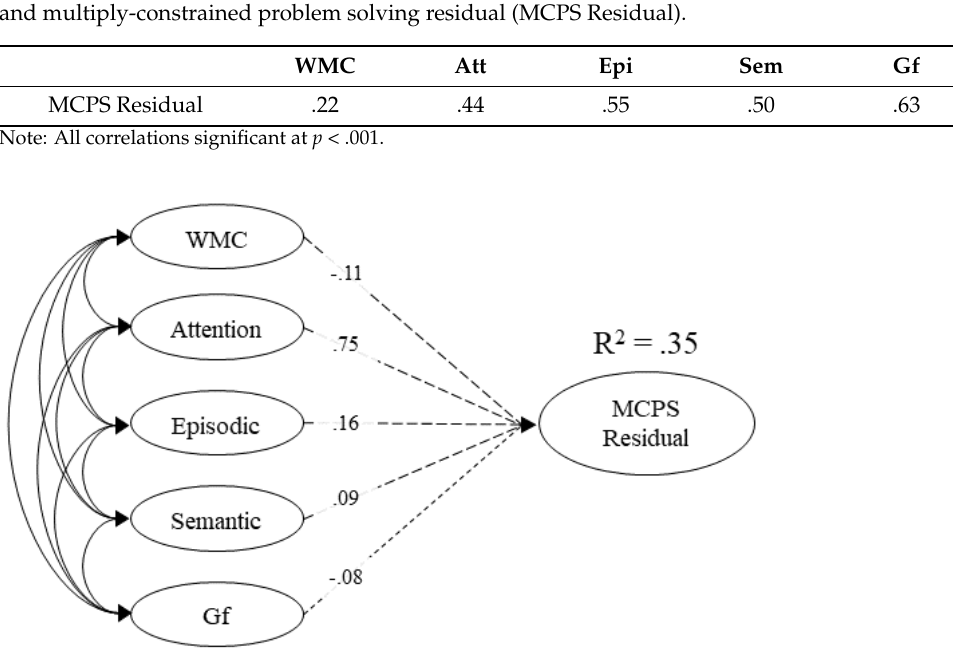
Figure 2. The full structural model of working memory capacity (WMC), attention control (attention), episodic memory (episodic), semantic memory (semantic), and fluid intelligence (Gf) loading on multiply-constrained problem solving residual, which is the remaining variance after accounting for shared variance between crystallized intelligence (Gc) and MCPS. Dashed lines represent nonsignificant paths. Values on paths represent standardized regression coefficients.